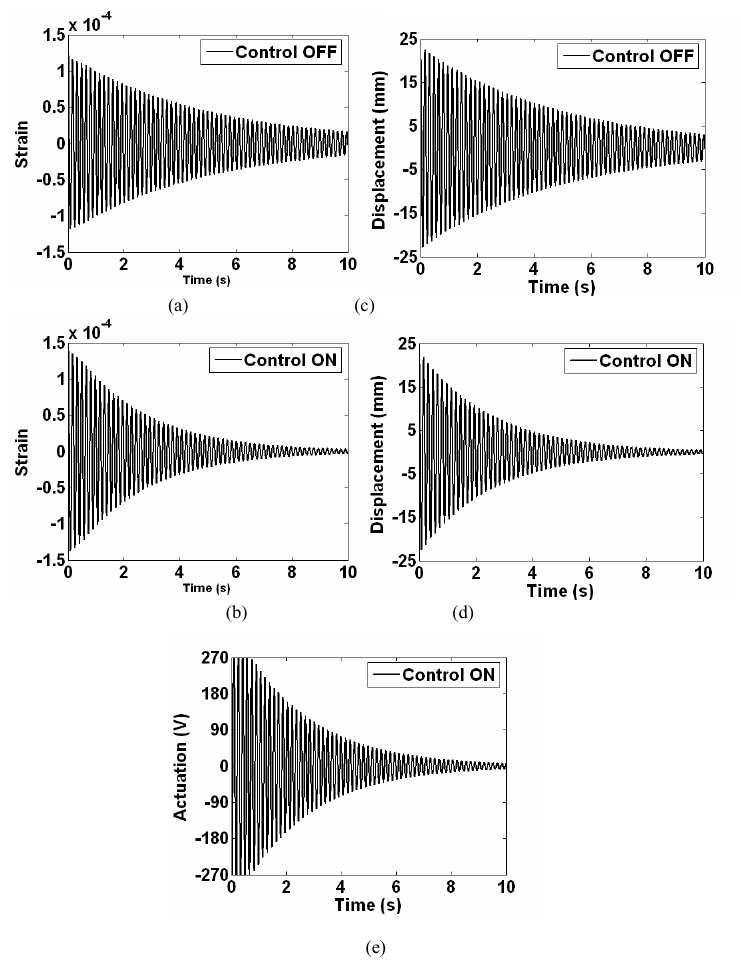
Fig. 3. Case 1 simulation results with strain feedback control for K p =